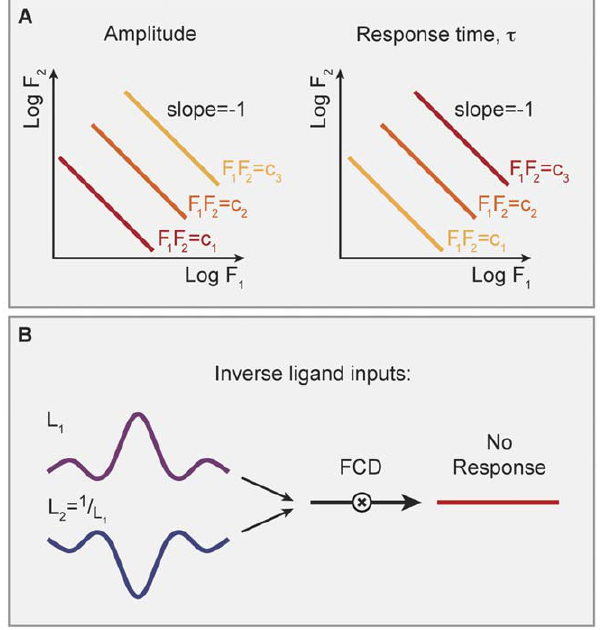
Figure 3. Log linear integration of signals. (A) Two inputs to the same receptor with equal number of binding sites are predicted to show linear equi-amplitude and equi-response time curves in the (log F 1 , log F 2 ) plane. Results shown are for the model of bacterial chemotaxis, with parameters y 0 =1,n=1. With increasing values of F 1 F 2 - amplitude rises (red to yellow) and response time decreases (yellow to red) (B) Two simultaneous input time curves which are inverse, namely L 1 (t)=c/L 2 (t), are predicted to yield no response.